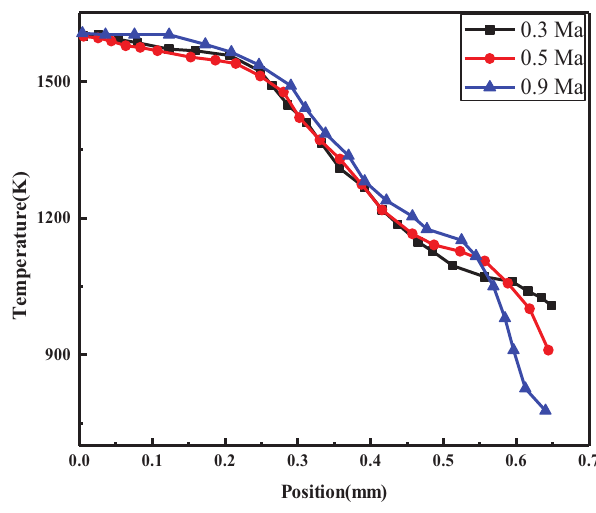
Figure 5: Gas temperature profiles from Mach 0.3 to Mach 0.9.